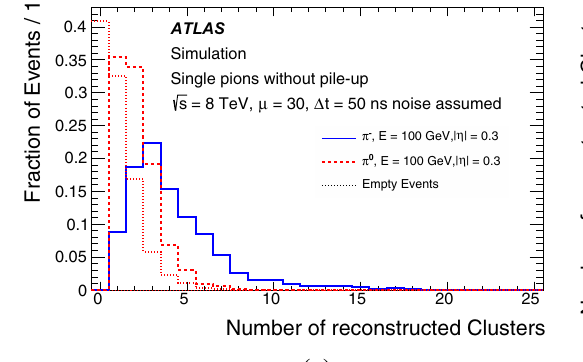
(topo-clusters generated by electronic noise only). The distributions are individually normalised to unity. The dependence of the average (cid:7) N clus (cid:8) on the generated η gen is shown in b again for π 0 , π − and empty events. The shaded area and the dashed lines indicate the spread (in terms of RMS) around the central